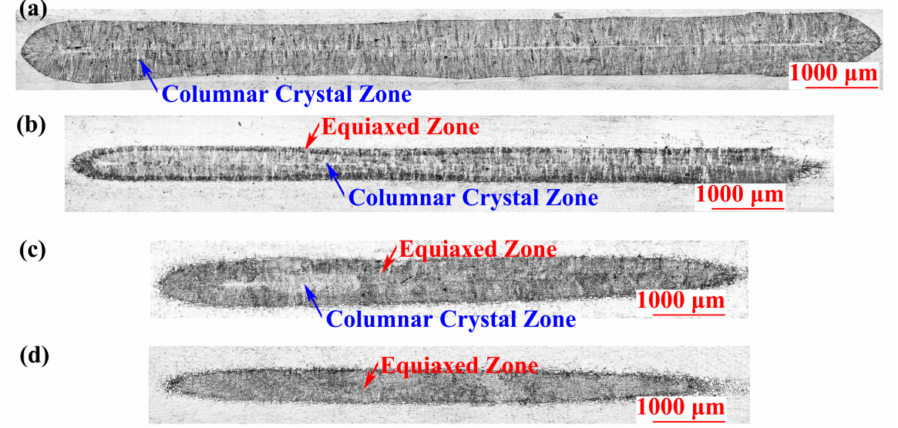
Figure 9. Metallographic morphology of RSW joints at di ff erent welding currents. The welding currents are ( a ) 16.5 kA, ( b ) 15 kA, ( c ) 14 kA, and ( d ) 13.5